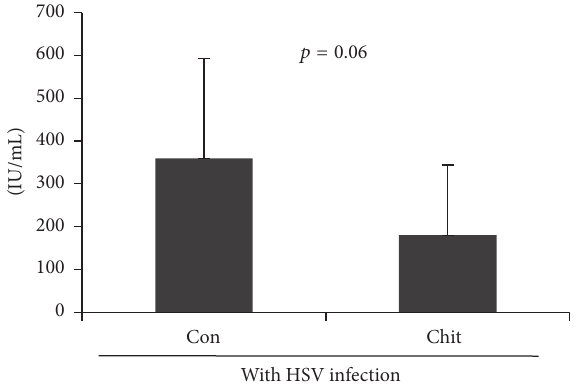
Figure 6: Anti-HSV antibody in chitosan treated and HSV infected mice. The levels of HSV antibody in chitosan treated group were analyzed by